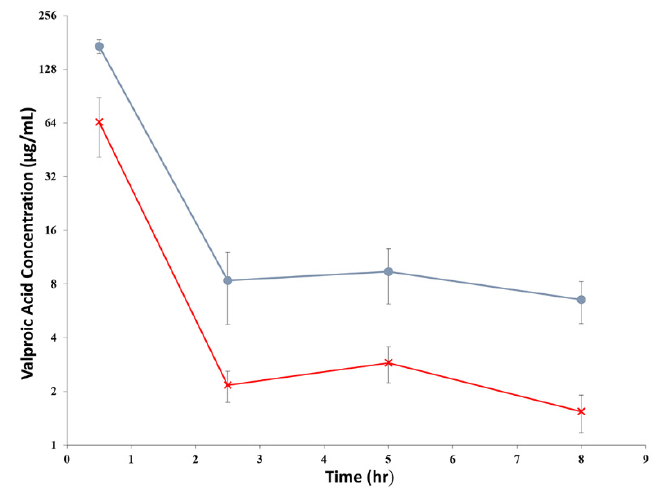
Figure 3. The of average VPA concentrations, µ g/mL (mean ± S.D., n = 10) in DBS in rats after given an intravenous dose of 200 mg/kg. The circle ( • ) represented the concentrations in female rats, while the cross ( × ) represented the concentrations in male rats. Table 1. Pharmacokinetic parameters estimated from the DBS drug levels following intravenous bolus administration of VPA in rats at dose of 200 mg/kg. Mean ± SD ( n =